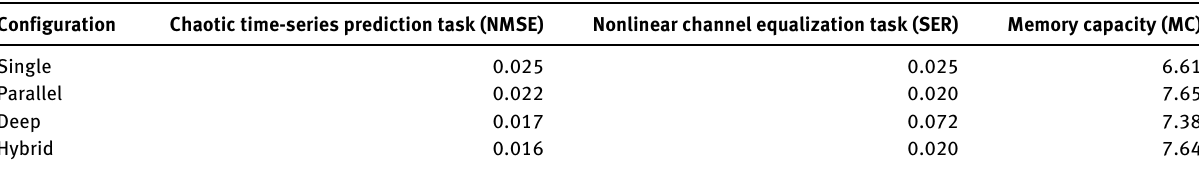
Figure 6: Memory capacity as a function of (a) the number of nodes N for each reservoir and (b) the total number of nodes N reservoirs for single (black), parallel (red), deep (brown), and hybrid (green) configurations. (a) N for parallel, deep, and hybrid configurations. (b) N Table 2: Comparison of the best performance among single, parallel, deep, and hybrid configurations in the chaotic time-series prediction task, nonlinear channel equalization task, and memory capacity measurement. The total number of nodes is N total = 800.